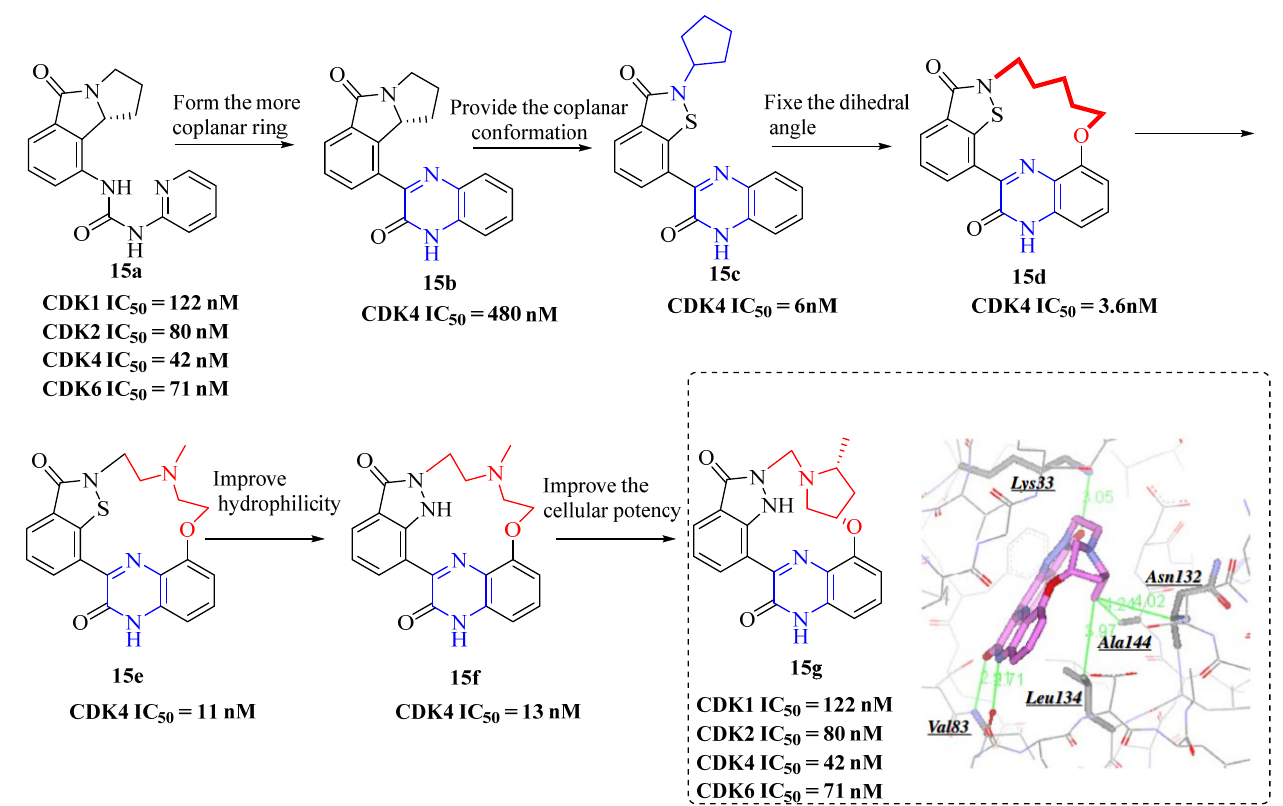
Figure 17. Structural modification of CDK inhibitors.